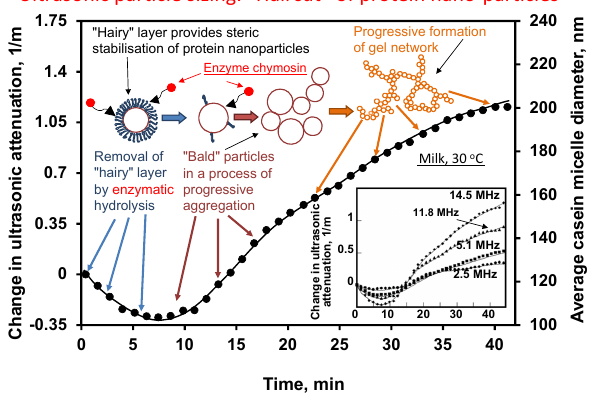
Figure 7. Ultrasonic monitoring of enzymatic haircut of protein nano particles (casein micelles). Main frame: ultrasonic attenua- tion measured at 14.5MHz in milk during the renneting process at 30 ◦ C. The enzyme chymosin was added to 1mL of milk in an ultrasonic cell of a HR-US 102 ultrasonic spectrometer (Ultrasonic Scientific, Dublin). The average particle size was calculated using HR-US particle size software module. Insert: effect of frequency on ultrasonic attenuation profiles measured during renneting of milk at 30 ◦ C. Adapted with permission from Dwyer et al. (2005). Copy- right ©Proprietors of Journal of Dairy Research